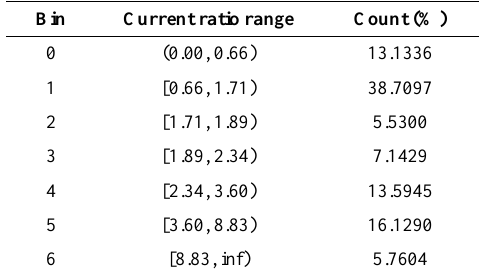
Table 3. Example of optimal bins of “current ratio” descriptors